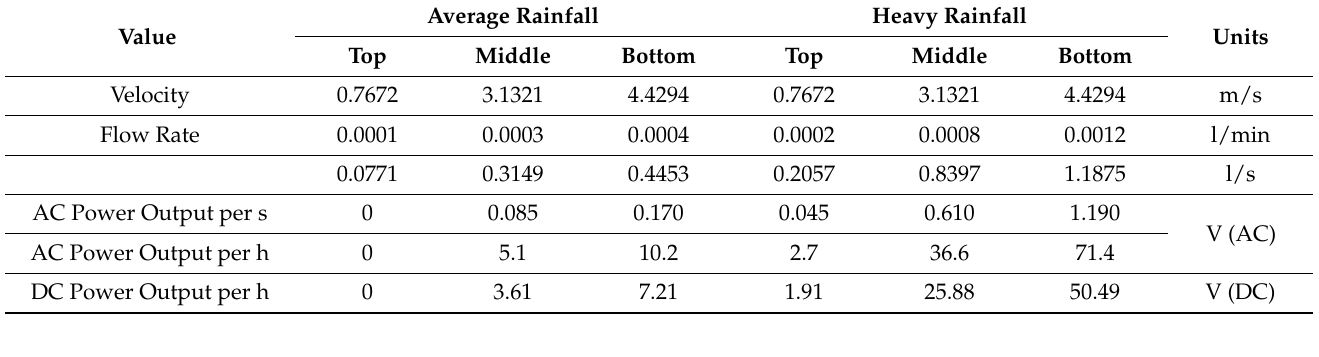
Table 3. Power generation at varying rainfall intensity.